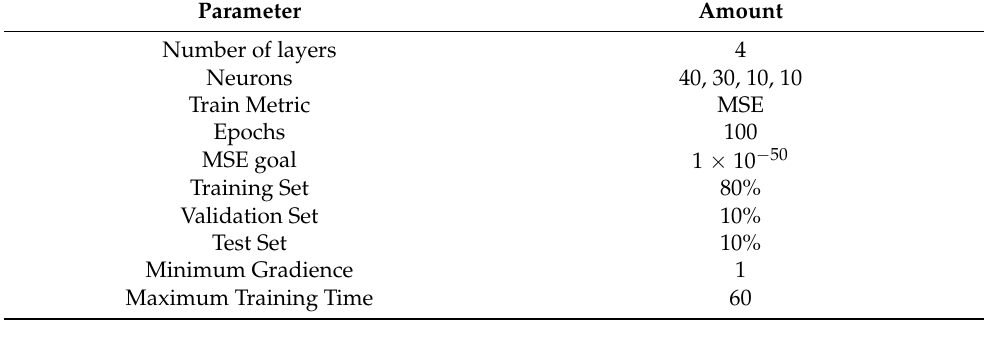
Table 2. FFNN model configurations and parameters.